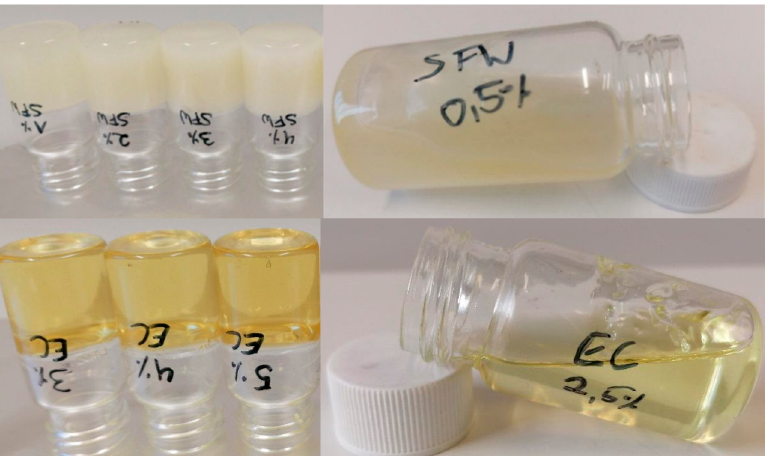
Figure 1. Upside-down test to determine critical structuring composition. After stabilization (48 h, 5 °C), sample vials with different compositions (1 to 10% ( w/w ) in 1% steps) are turned upside down. Stable composition left, instable composition at intermediate composition right. Top row sunflower wax in canola oil (0.5%); bottom ethylcellulose (100) in canola oil (2.5%) [66]. This method is practical, but it deserves some attention concerning what is